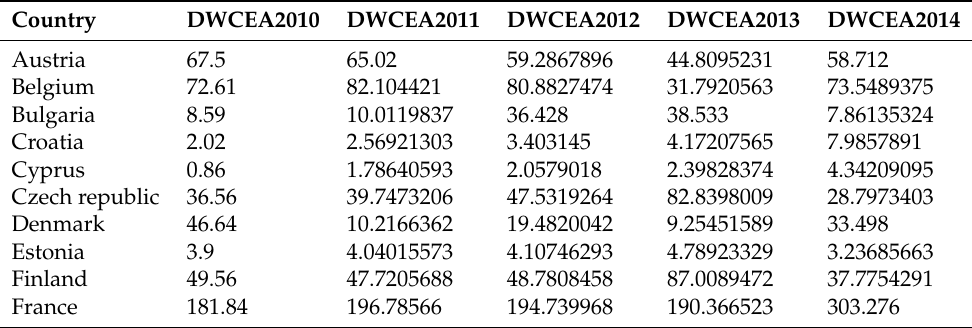
Table A5. Allocation vectors provided by the DWCEA solution for each year in the interval 2010–2014 (values are in millions of tons of CO 2